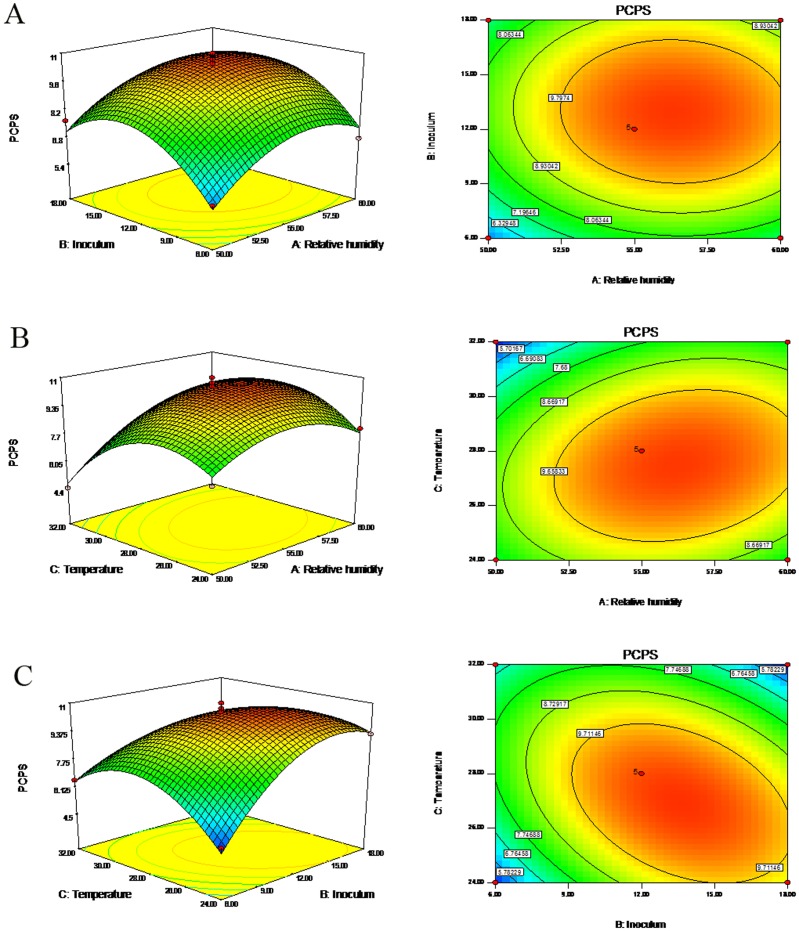
Response surface (left) and contour (right) plots for the effects of three variables on PCPS from P. cicadae.(A), response surface plot showing the mutual effect of relative humidity and inoculum on the production of PCPS; (B), response surface plot showing the mutual effect of relative humidity and temperature on the production of PCPS; (C), response surface plot showing the mutual effect of inoculum and temperature on the production of PCPS.